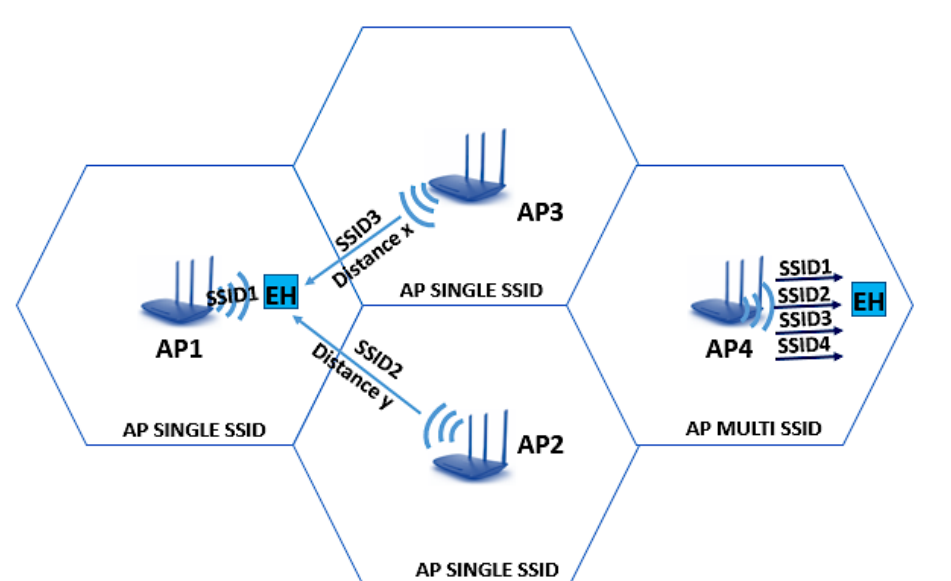
Figure 4. EH WiFi Scenario with Single SSID and Multiple. SSID APs.